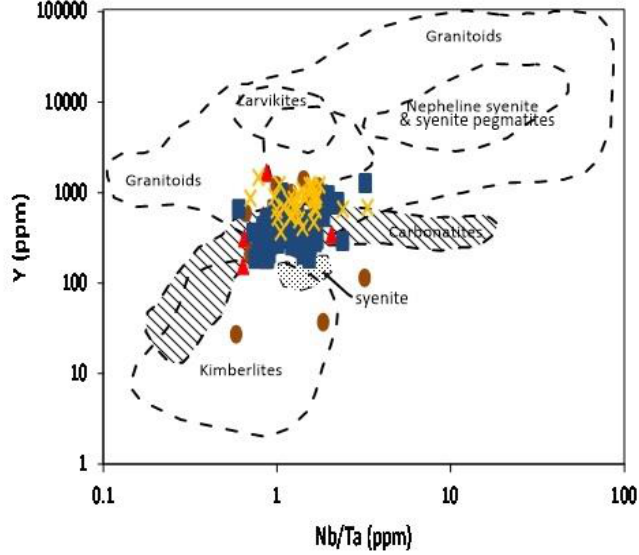
Figure 10. Y versus Nb/Ta plot for southern Meiganga detrital zircons (the lithounit fields are from [4,71]). Red triangles represent zircon with Th/U < 0.2; blue squares represent zircon with Th/U ratios [0.2 to 0.5]; brown circles represent zircons with Th/U ratios [>0.5 to 1.0]; and stars represent zircons with Th/U > 1.0).